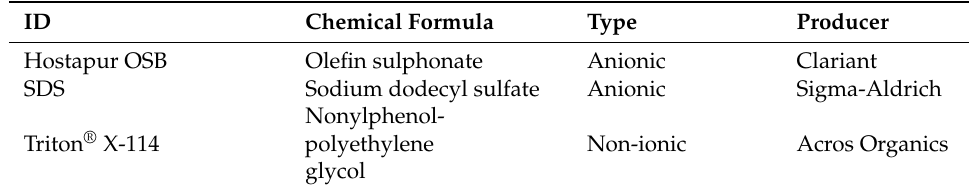
Table 1. Characterization of